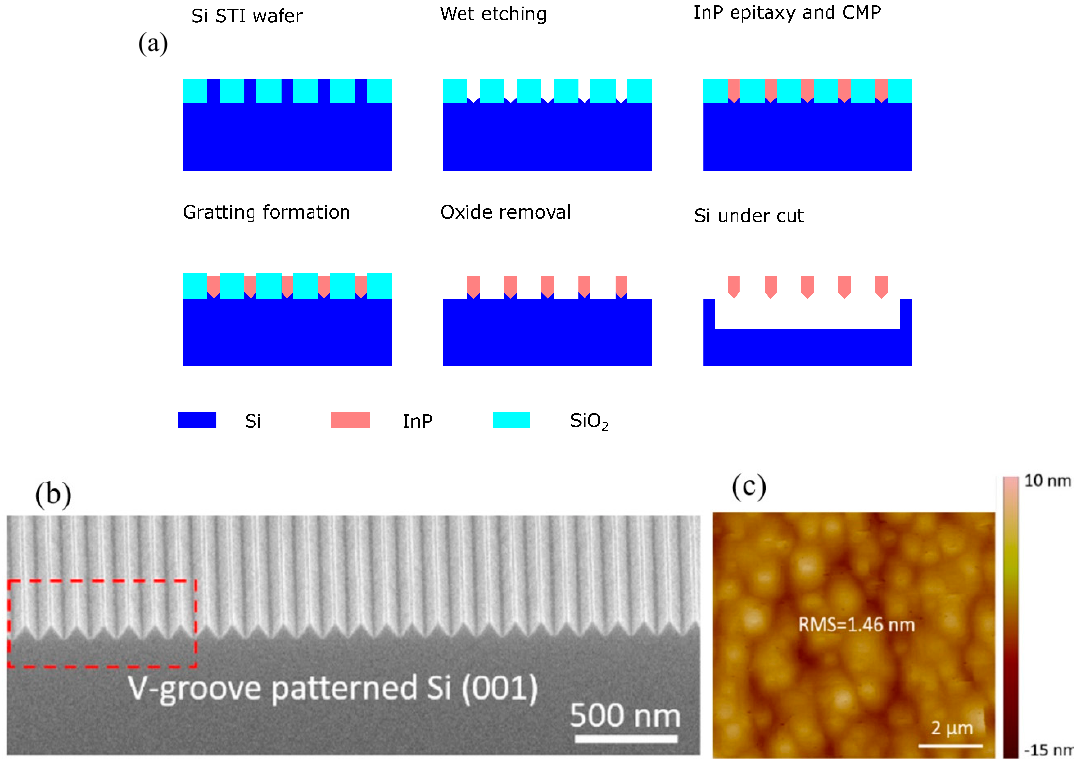
Figure 47. ( a ) V-groove aspect ratio trapping (ART) process flow, ( b ) the SEM diagram of the tilted V-groove patterned Si and, ( c ) the atomic force microscope (AFM) of GaAs on patterned Si, respectively [333].